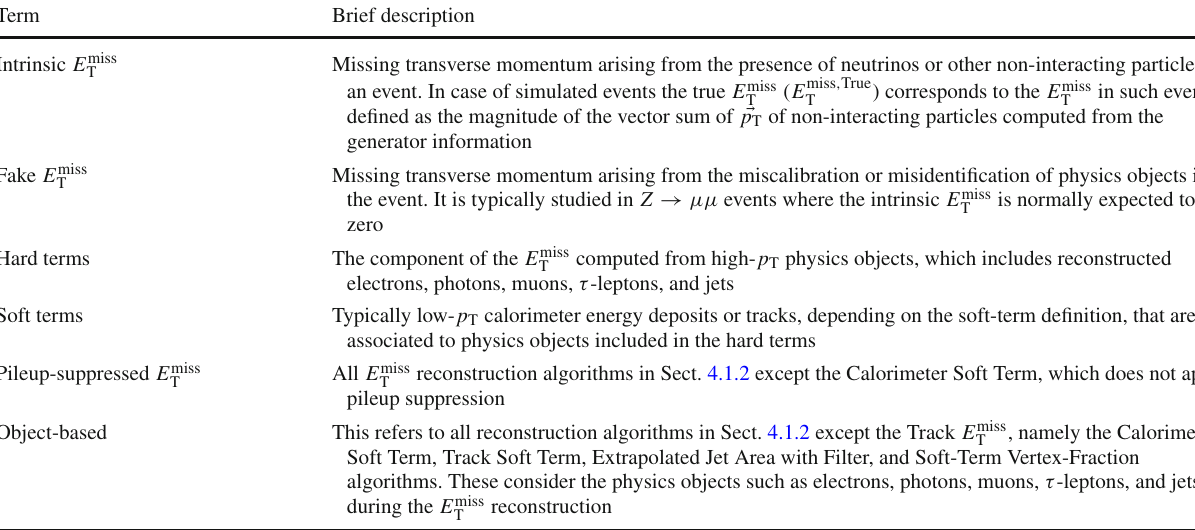
terms used in this T